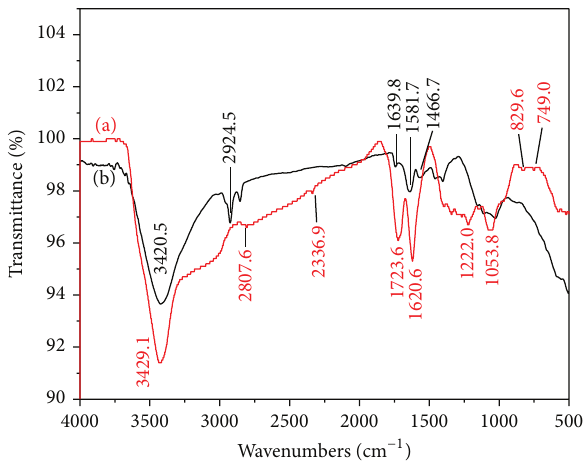
Figure 2: FTIR spectra of GO (a) and PDDA-G (b).